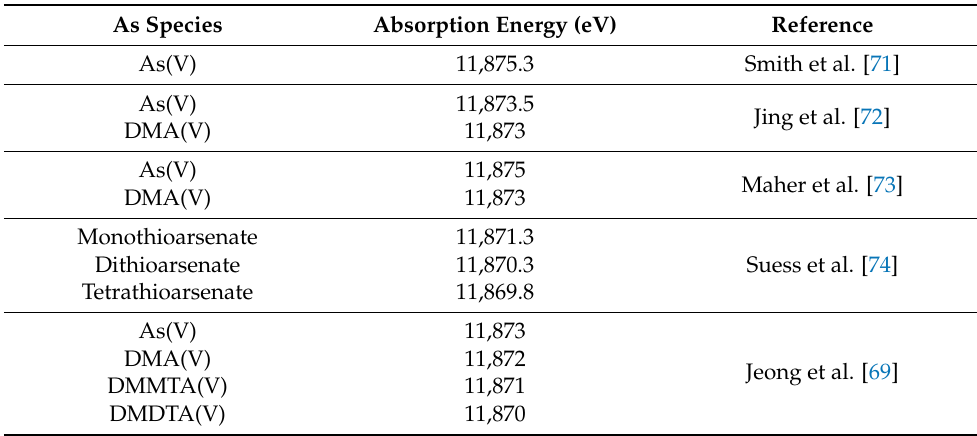
Figure 3. As reference compounds (As(V), DMA(V), DMMTA(V), and DMDTA(V)) and K-edge XANES spectra for two-line ferrihydrite, to which each As species was adsorbed. The dashed line represents the absorption energy of 11,873.8 eV. Table 3. Absorption energy (white-line energy position) (eV) of As